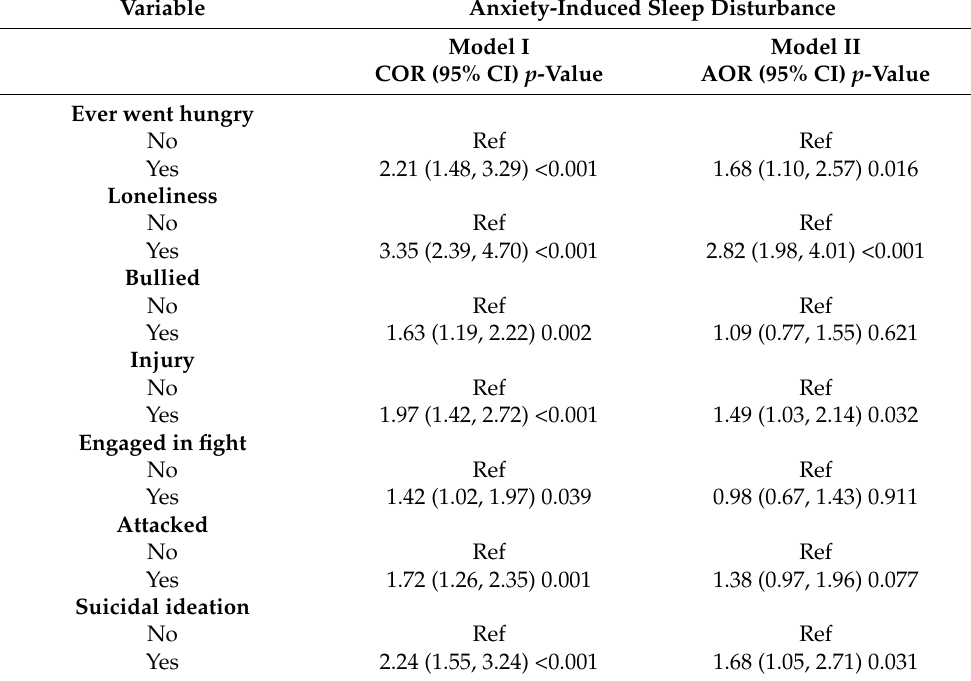
Table 2. Multivariable Analysis on Predictors of Anxiety-induced sleep disturbance among In-school Adolescents in